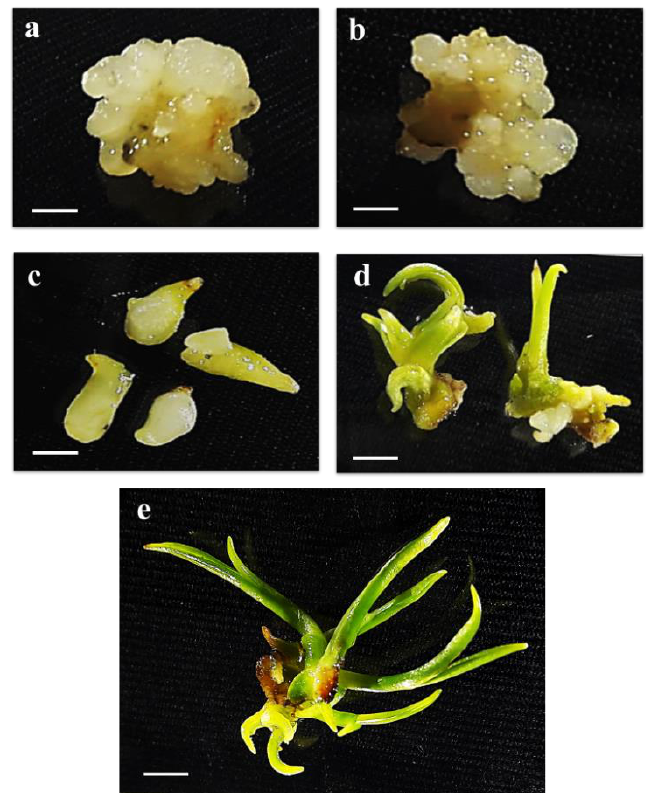
Figure 1. Elaeis guineensis Jacq cv “Tenera” developmental stages of somatic embryogenesis. ( a ) embryogenic callus (bar = 0.25 cm), ( b ) globular (bar = 0.25 cm), ( c ) torpedo (bar = 0.25 cm) ( d ) cotyledonary (bar = 0.25 cm), and ( e ) plantlet (bar = 0.25 cm) stages.